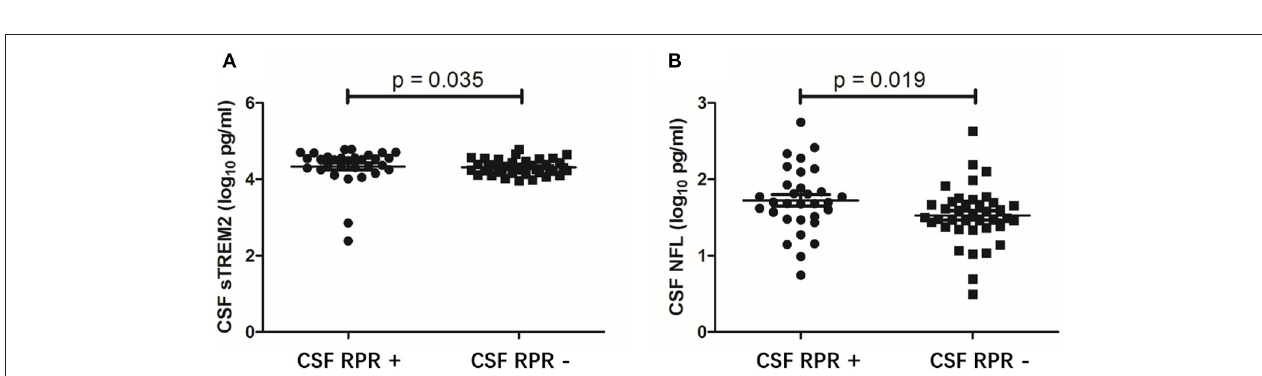
FIGURE 4 | CSF levels of sTREM2 and NFL in NS patients with CSF RPR positive and CSF RPR negative. (A) The CSF sTREM2 (log 10 pg/ml) levels in CSF RPR positive patients were significantly higher than in CSF RPR negative patients. (B) The CSF NFL (log 10 pg/ml) levels in CSF RPR positive patients were significantly higher than in CSF RPR negative patients. CSF, cerebrospinal fluid; sTREM2, soluble triggering receptor expressed on myeloid cells 2; NFL, neurofilament light protein; RPR, rapid plasma